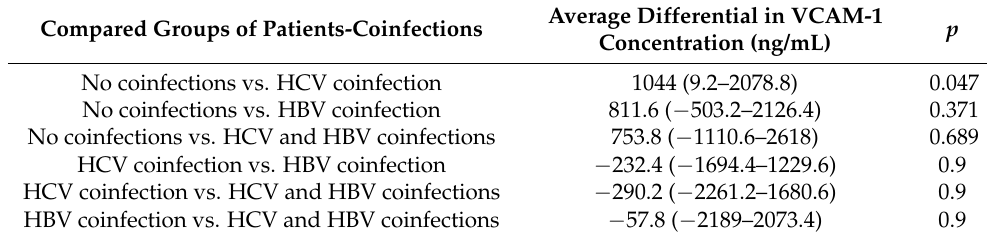
Table 5. The results of the Tukey HSD test comparing coinfections and VCAM-1 concentration.